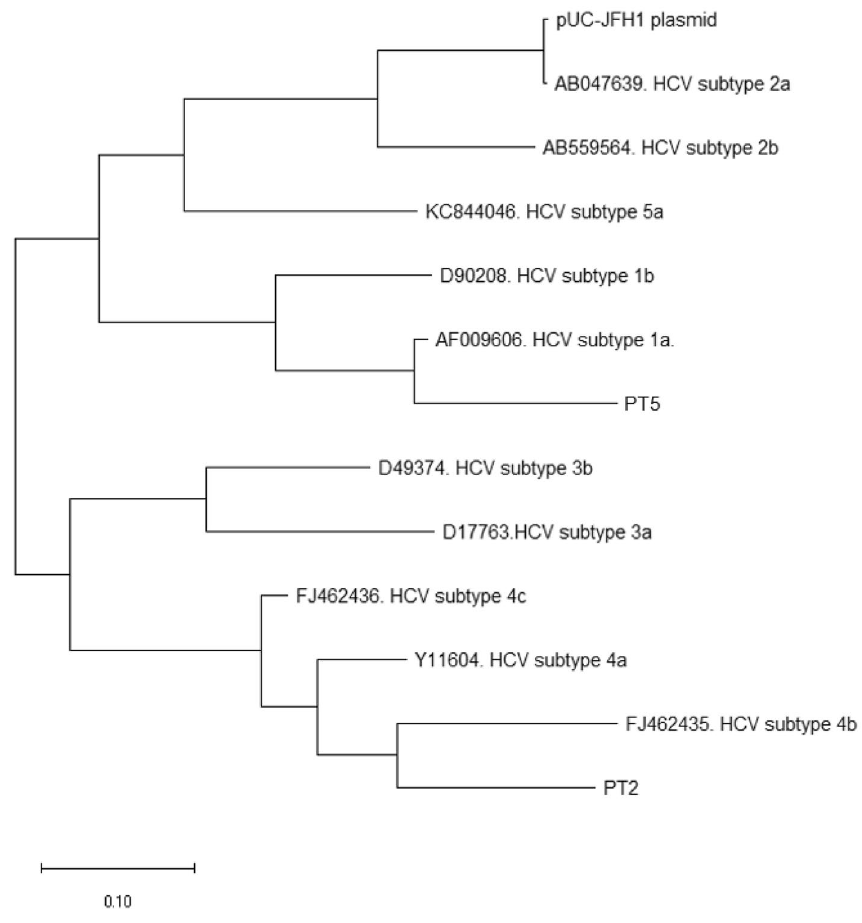
Figure 5. Phylogenetic tree of NS5B region from HCV reference sequences, pUC-JFH1 plasmid, and sequence results from PCR of samples PT2 and